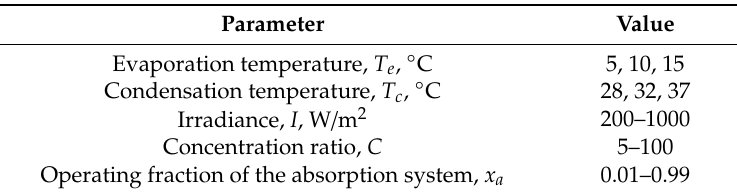
Table 2. Parameters changed for the simulation.